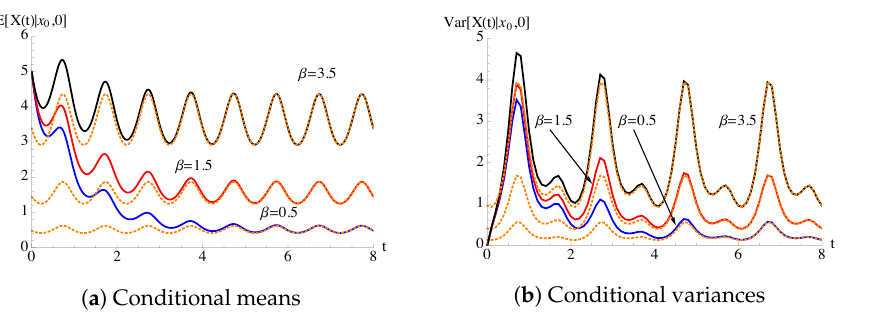
(cid:0) (cid:1)(cid:2) (cid:0) (cid:1)(cid:3) − 1 2 π t 1 + 0.2 sin 2 π t